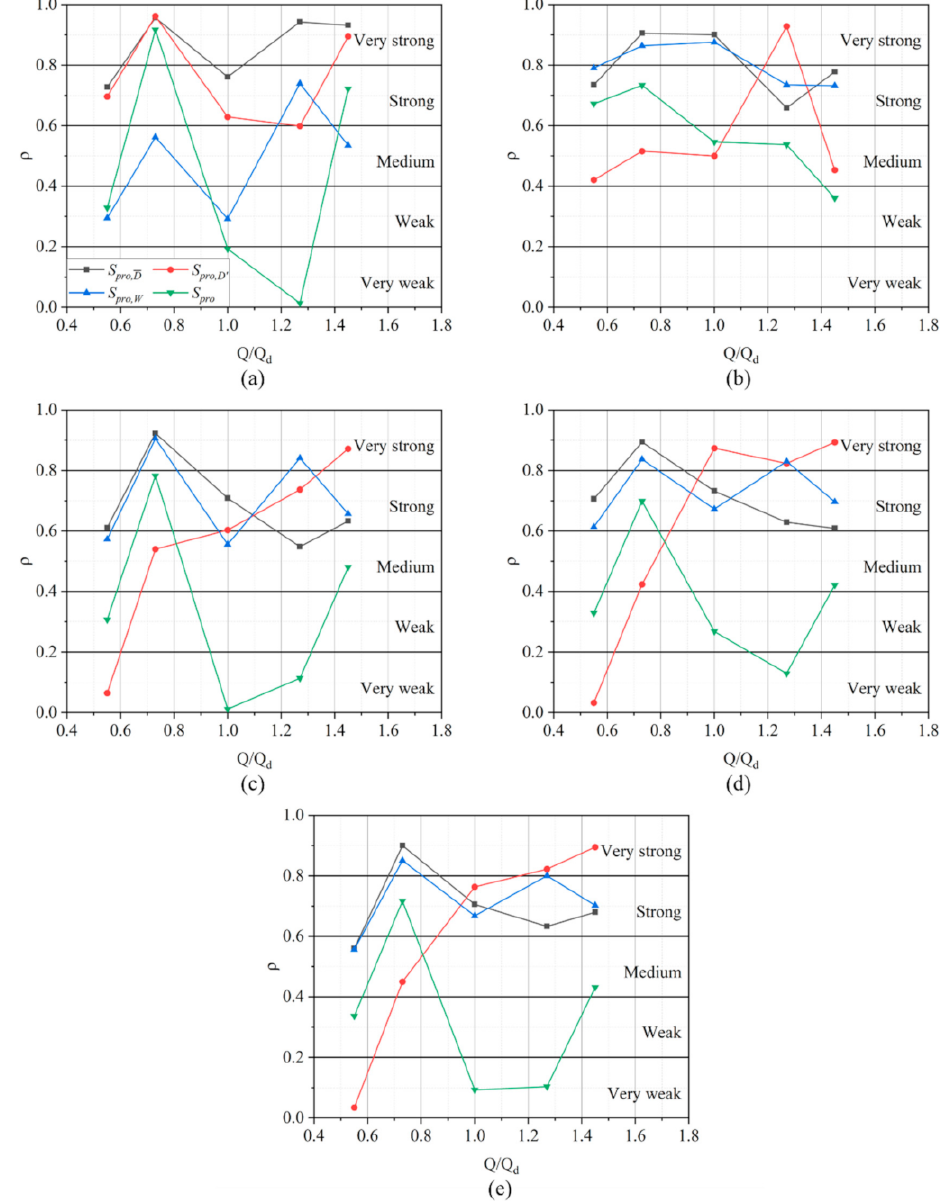
Figure 22. Correlation between transportation effect and entropy production. ( a ) guide vane1, ( b ) guide vane2, ( c ) guide vane3, ( d ) guide vane 4, ( e ) guide vane